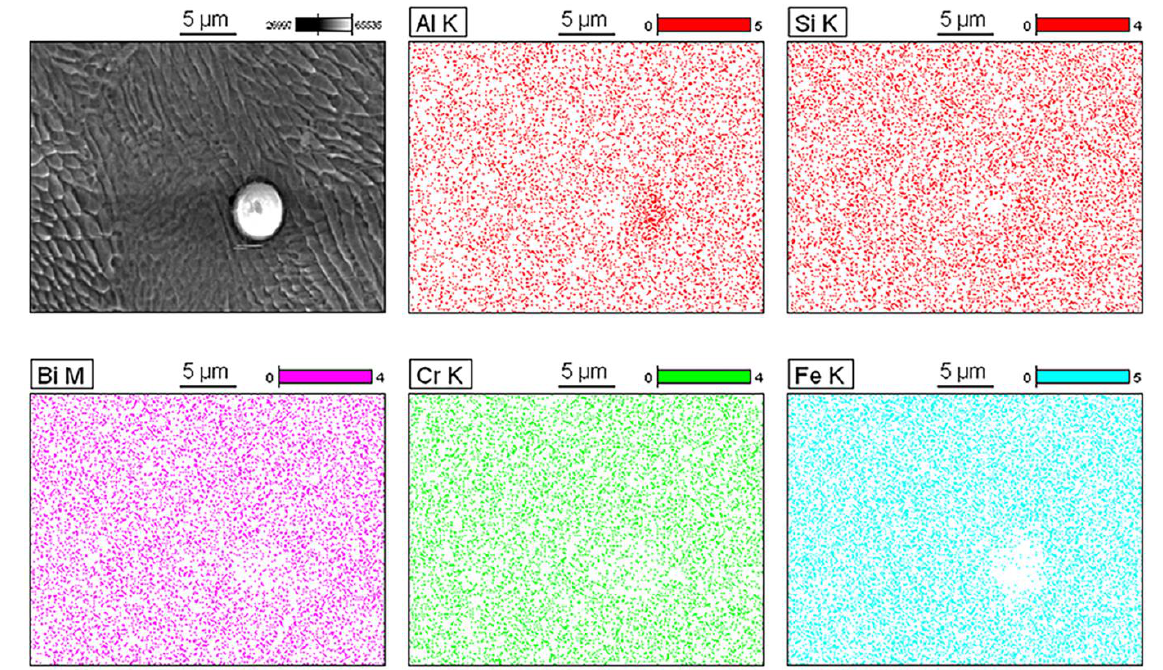
Figure 17. EDX analysis of the residual particles using energy dispersive X-ray mapping with key elements shown.